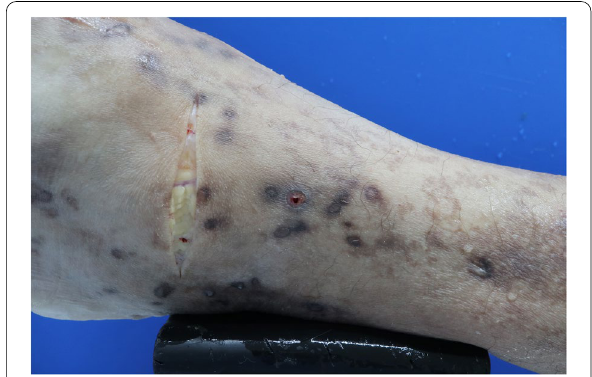
Fig. 1 Lateral aspect of left leg with chronic venous disease and Fig. 3 The scene of death: victim’s lower limbs surrounded by a large amount of